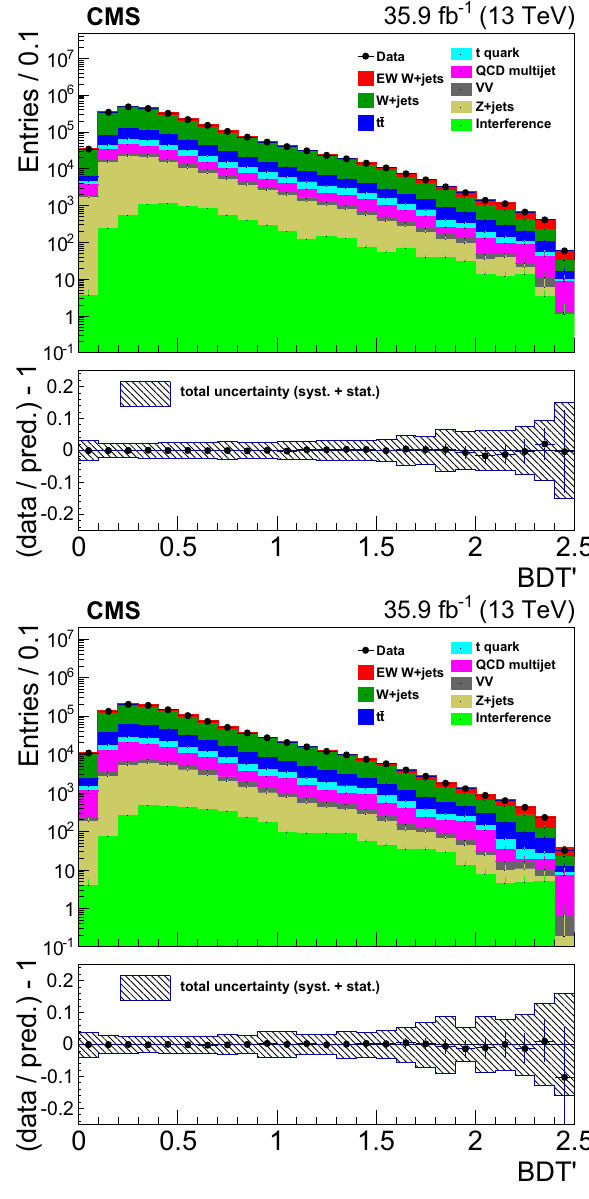
Fig. 9 DatacomparedwithsimulationfortheBDT’outputdistribution forthemuon(upper)andelectron(lower)channels,afterthefit.Thegrey uncertainty band in the ratio panel includes all systematic